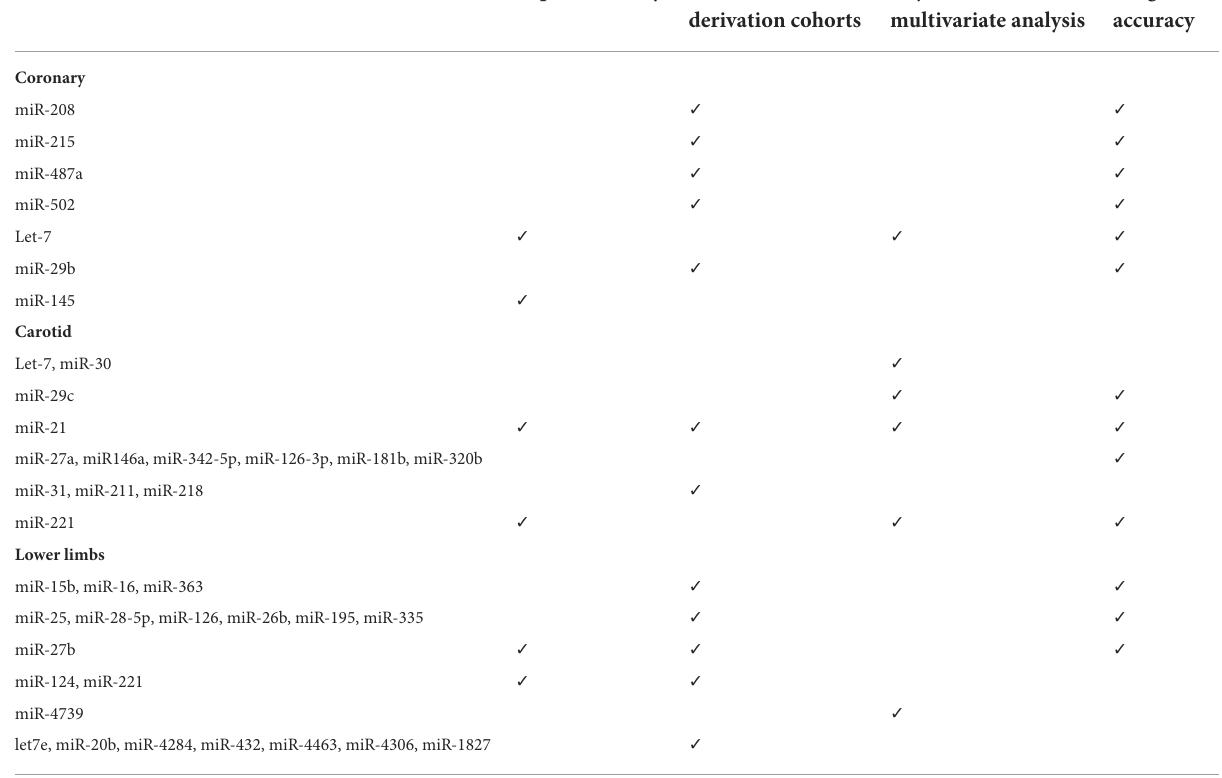
TABLE 2 Robustness of miRNA dysregulation in atherosclerosis of different territories. miRNAs Reproducibility Validation